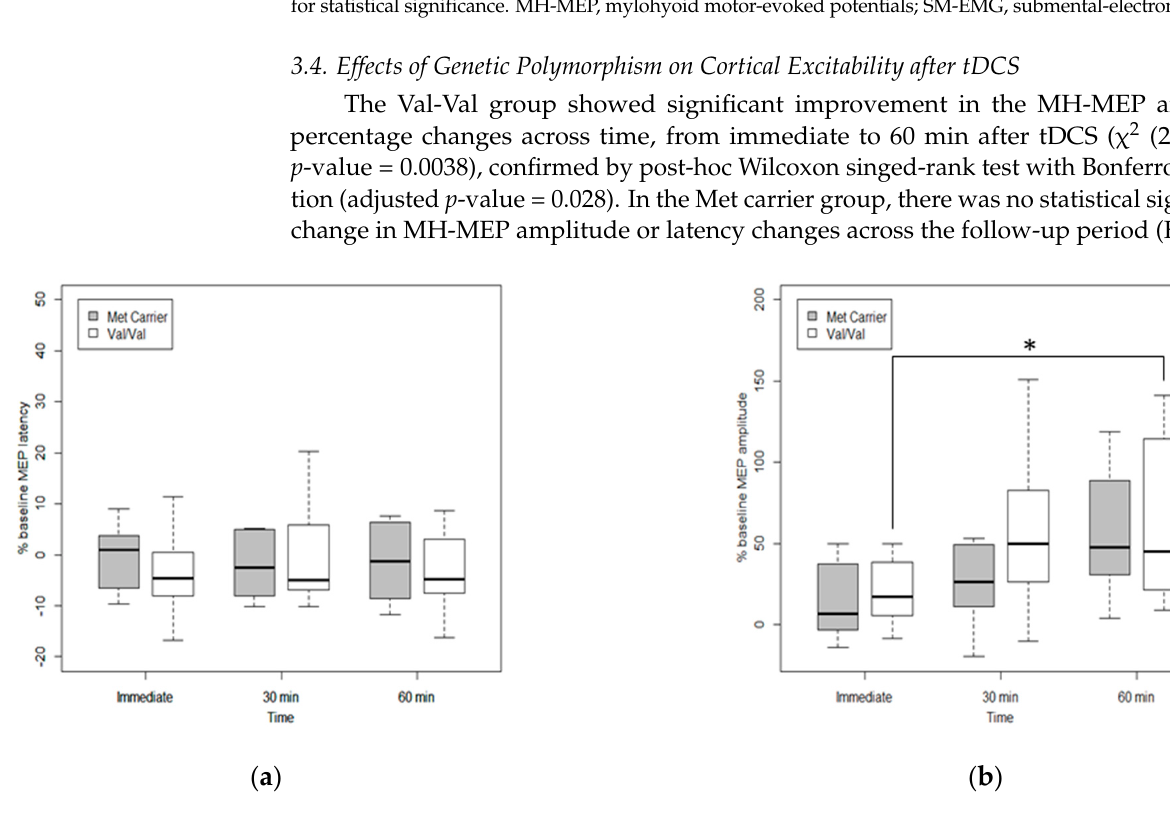
Figure 3. Cortical excitability changes across time according to COMT polymorphism. ( a ) Percentage changes of MH-MEP latencies and ( b ) MH-MEP amplitudes. The Val/Val group showed significant improvement MH-MEP amplitude percentage change across time from immediate to 60 min after tDCS ( χ 2 (2) = 11.17, p -value = 0.0038), confirmed by post hoc Wilcoxon signed-rank test and Bonferroni correction (adjusted p -value = 0.028). Statistically significant time intervals are indicated by a solid line and an asterisk (*).